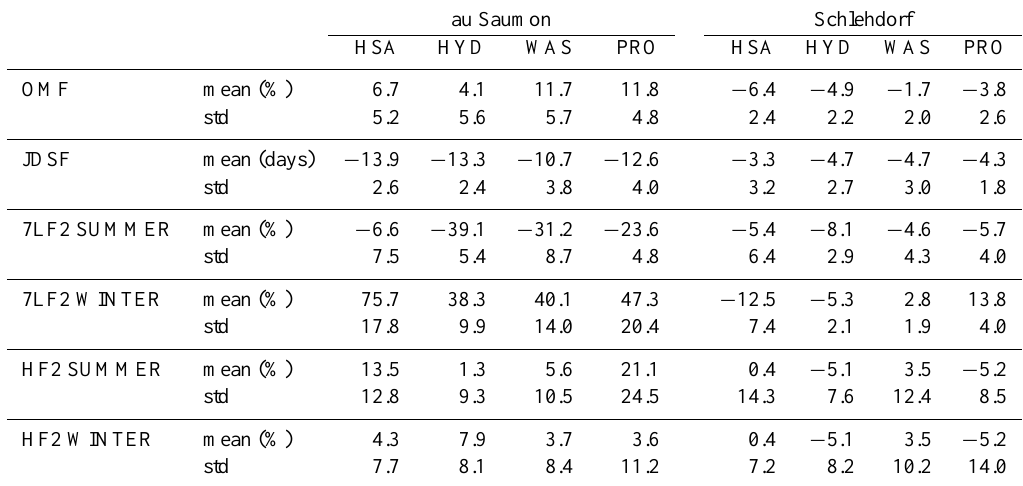
Table 3. Mean and standard deviation (std) from the change series presented in Figs. 7 and 8. au Saumon Schlehdorf HSA HYD WAS